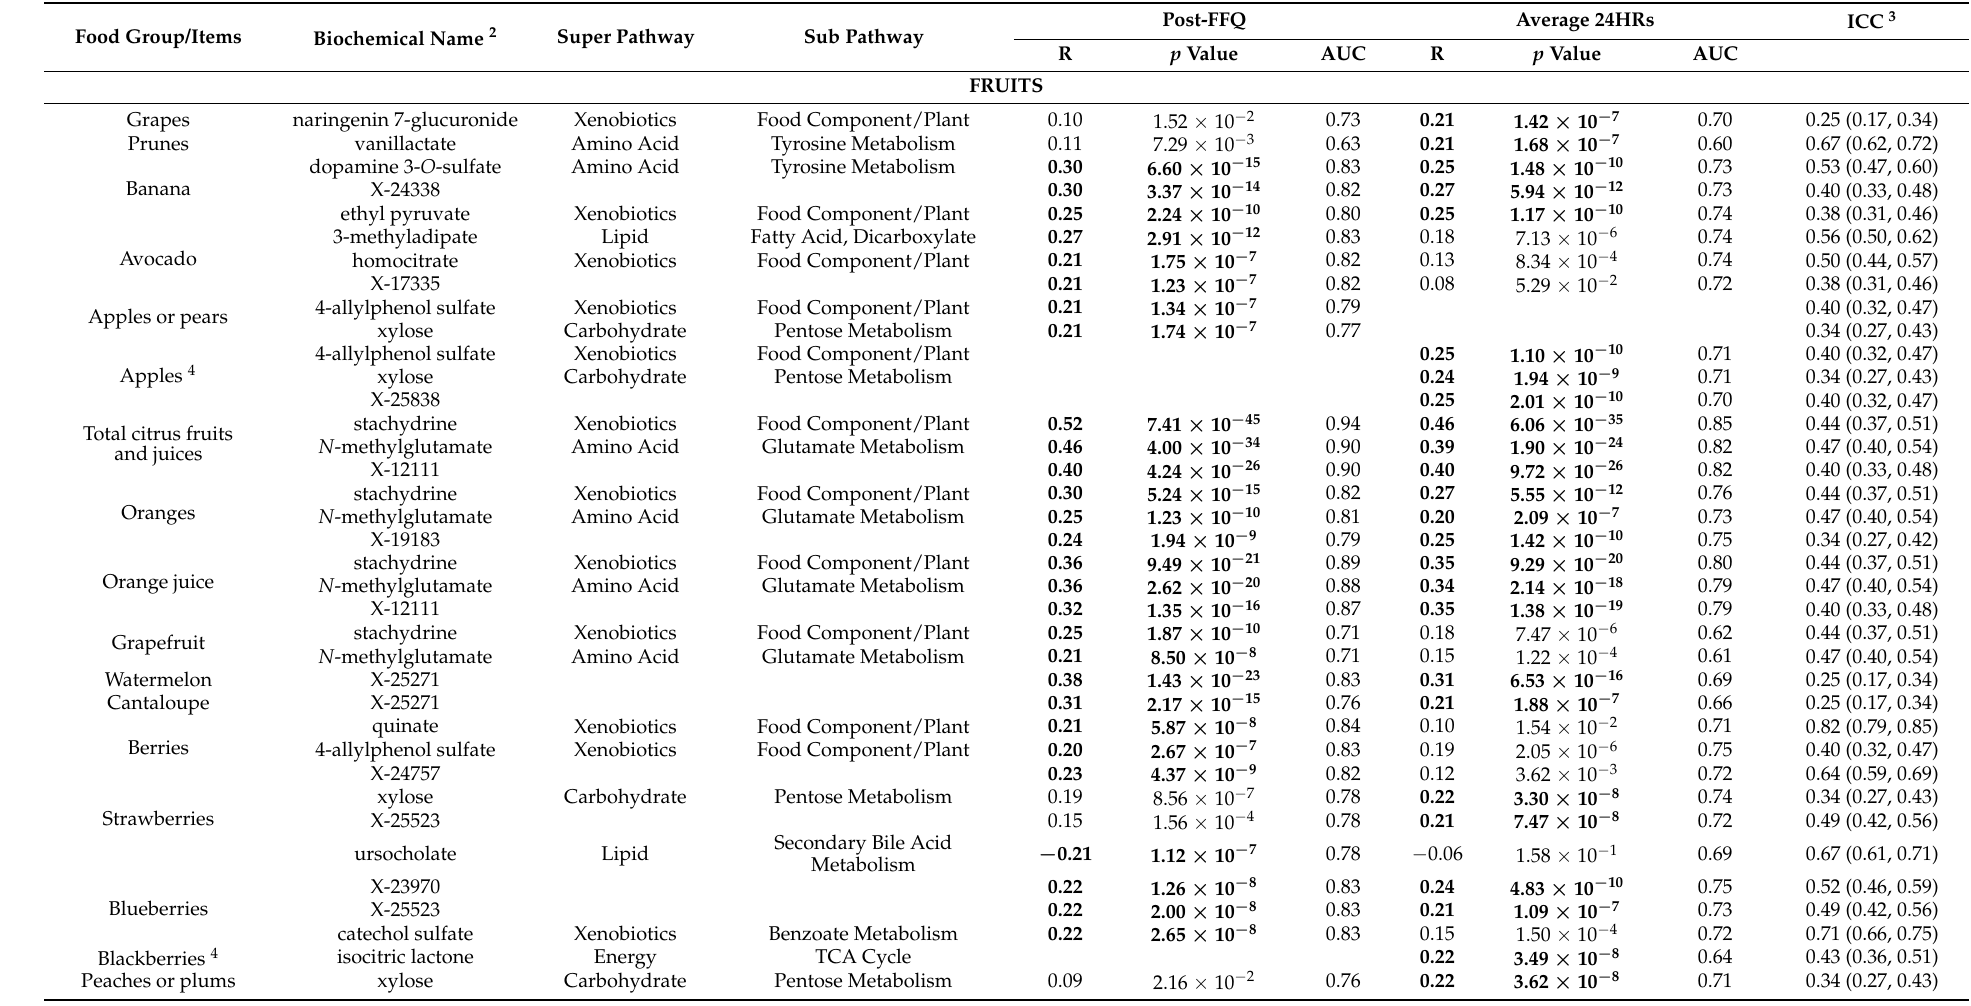
Table 2. Top three predictive metabolites for 79 food group/item assessed using the CPS-3 FFQ and average of 24 h diet recalls in the Cancer Prevention Study-3 Diet Assessment Sub-study 1